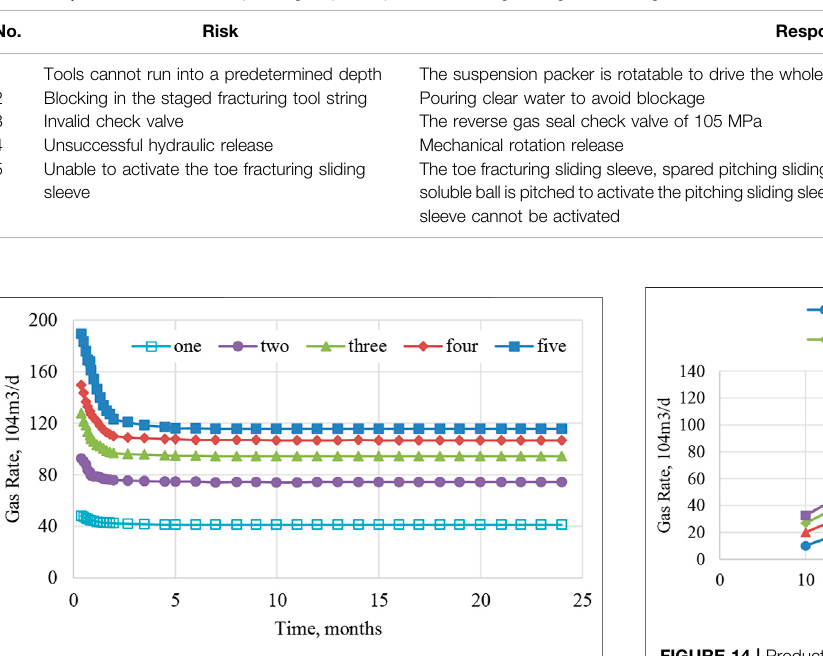
TABLE 4 | Main risks and corresponding response plans for running in staged fracturing tools.